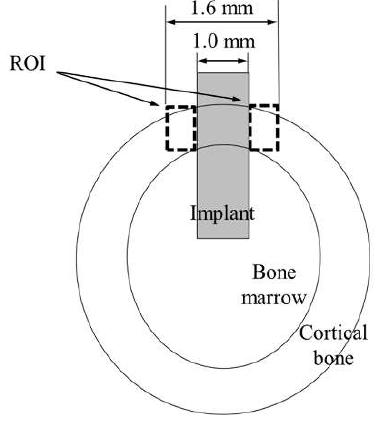
Figure 3. Schematic of the ROI.